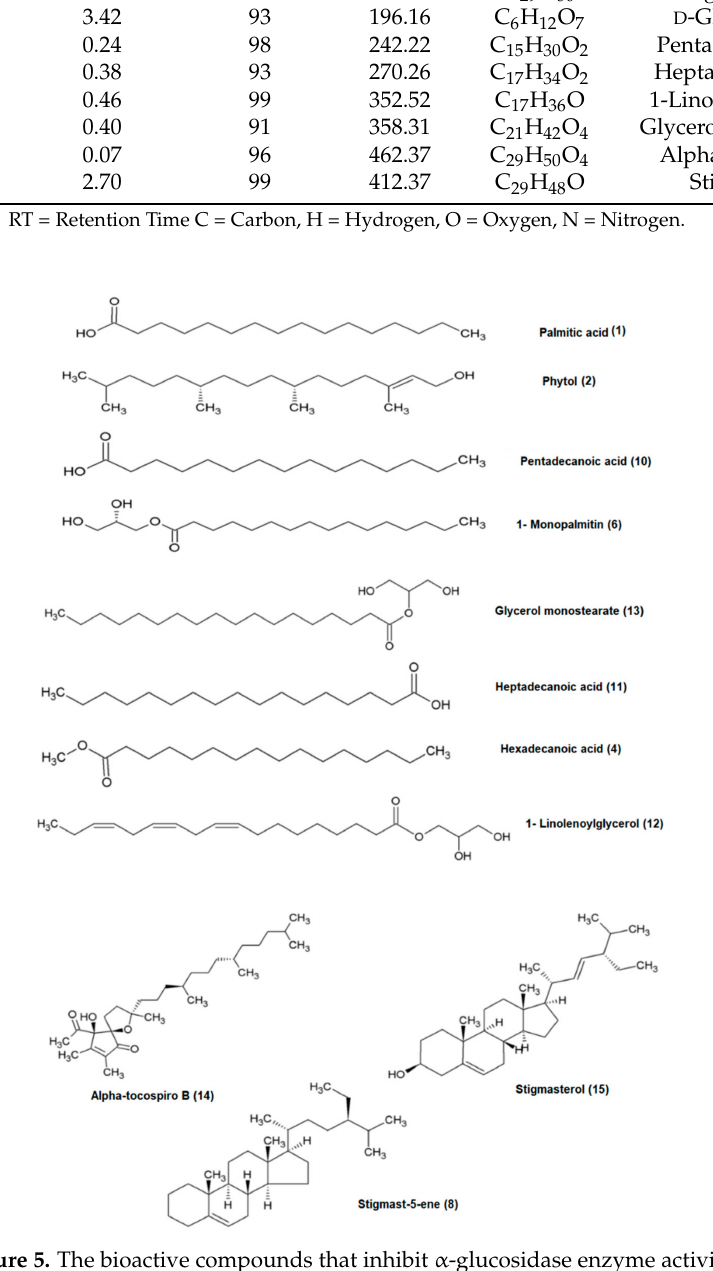
Figure 5. The bioactive compounds that inhibit α -glucosidase enzyme